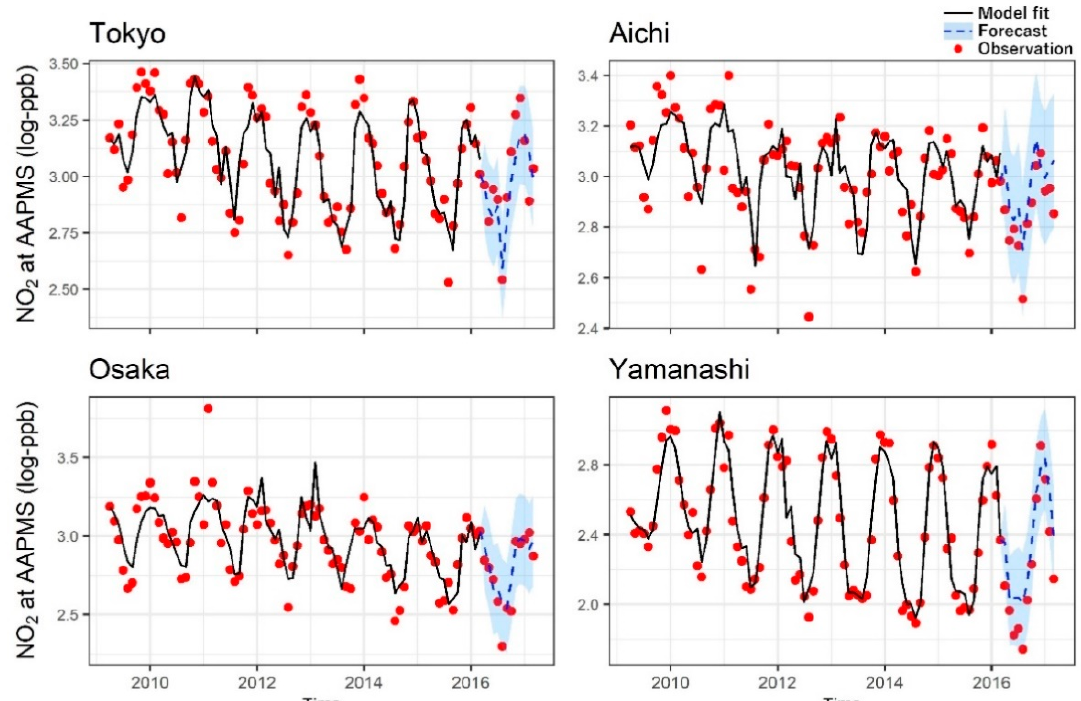
Figure 2. Fitting and forecasting for nitrogen dioxide (NO 2 ) concentration at ambient air pollution monitoring stations (AAPMSs) using seasonal autoregressive integrated moving average (SARIMA) models. Log scale NO 2 concentrations were used for the analyses. Red dots are observations. Black lines show model fits for NO 2 using data in April 2009–March 2016 (training data). Blue dotted lines (estimates) and shadows (95% confidence intervals) show the forecasting for NO 2 using data in April 2016–March 2017 (testing data).